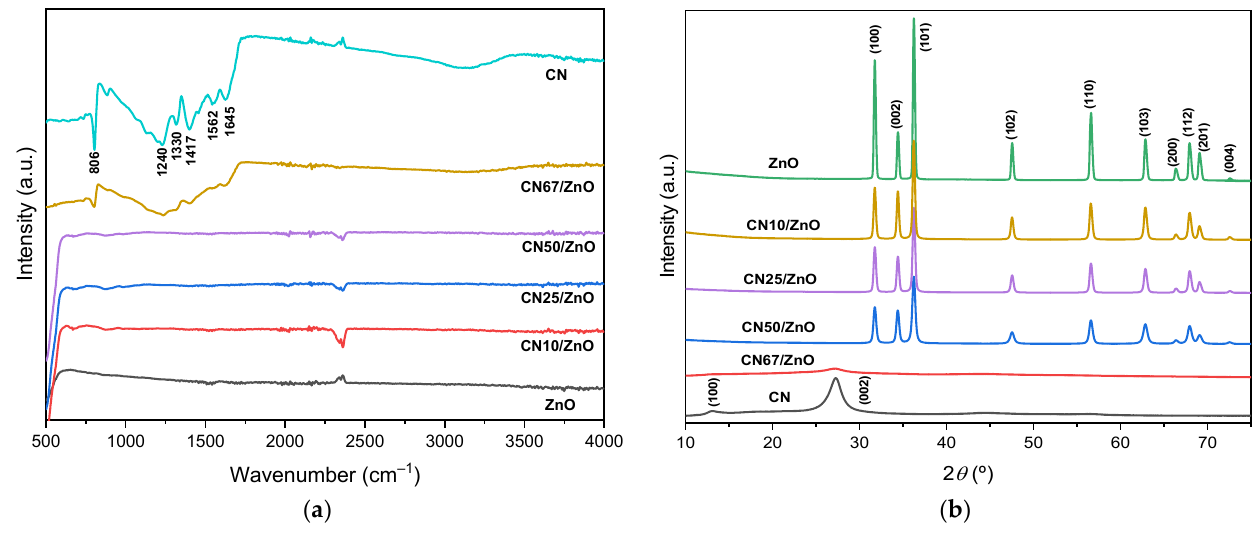
Figure 1. ( a ) FTIR spectra and ( b ) XRD patterns of pure CN, pristine ZnO, and CN/ZnO composites.